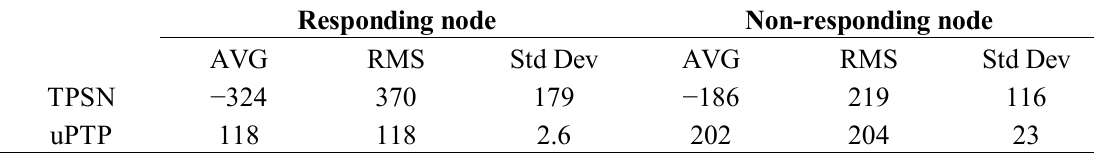
Table 3. Synchronization results via clock drift correction.